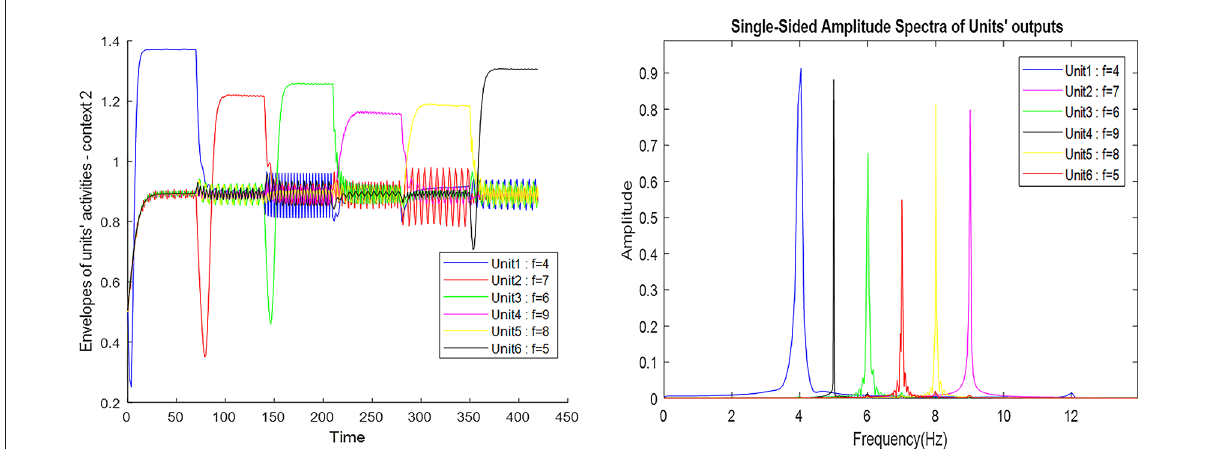
FIGURE7 The outputs of the Van-der-pol neuron model proposed in this article to model neuronal ensembles in the PRC region. The simulation results are shown as neuronal units’ responses to input excitations (landmarks 1–6), in the order of encountering based on the route of each context. Left column: amplitude envelope for neuronal units’ responses to input excitations for context 2. Right column: frequency spectrum of neuronal units’ responses to landmarks of context 2. Frequencies 4–9 in this figure are equivalent to main landmarks 1–6 in Figure 3 , where their sequential order and consequently the route is different in contexts 1 and 2. The parameters for the Van-der-pol model in this simulation are λ = 0.2, B 1,...,6 = 1.5, A s = 1, P 1,...,6 = 4, 7, 6, 9, 8, 5, ω s = 4, 7, 6, 9, 8, 5. 1,...,6